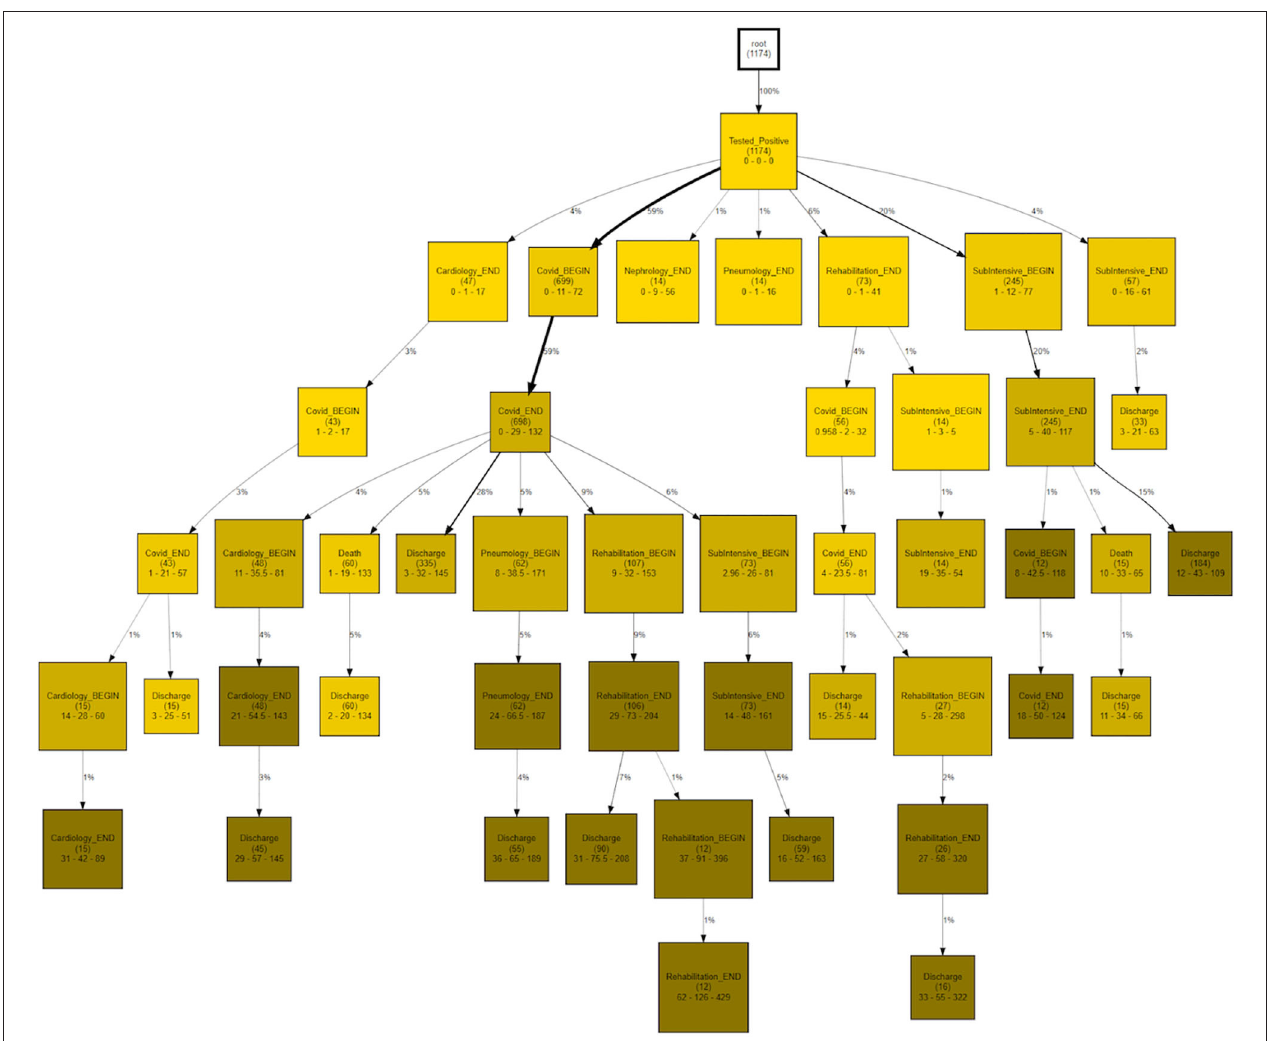
FIGURE 10 | CareFlow miner results - time from the first event